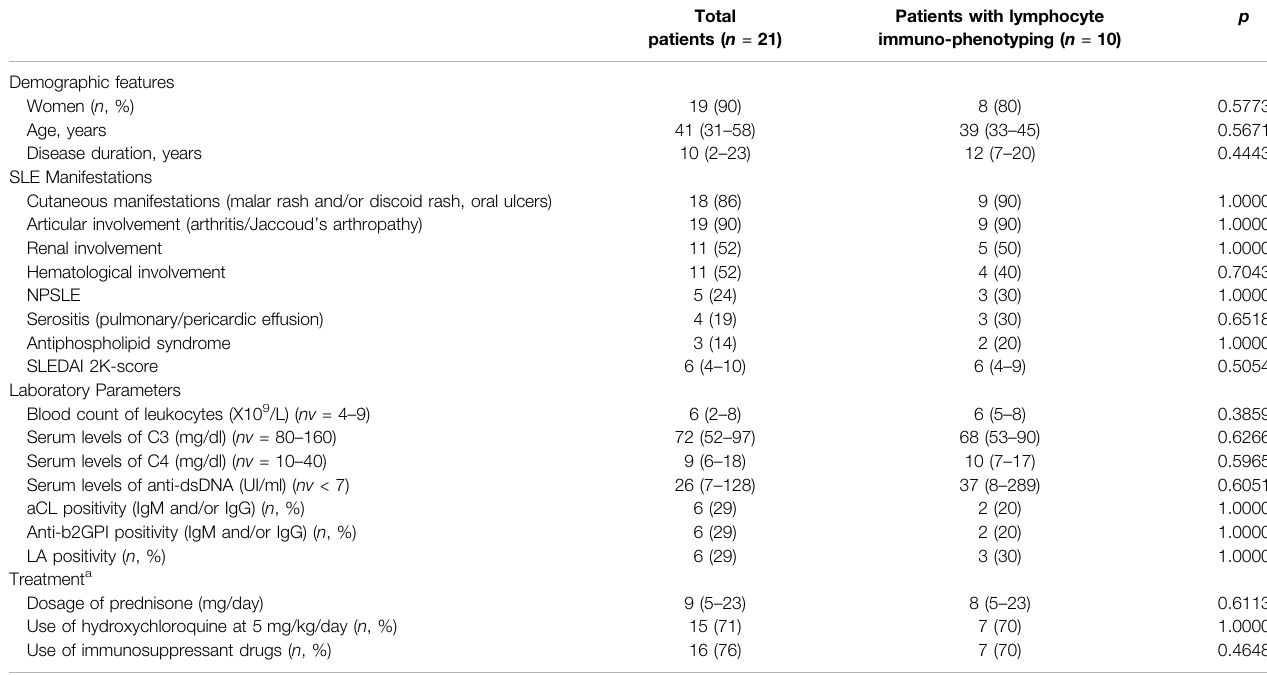
TABLE 1 | Demographic, clinical and laboratory features of SLE patients at baseline.